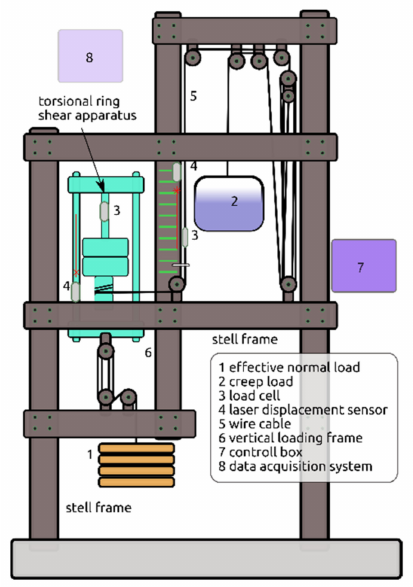
Figure 1. Structural features of creep test